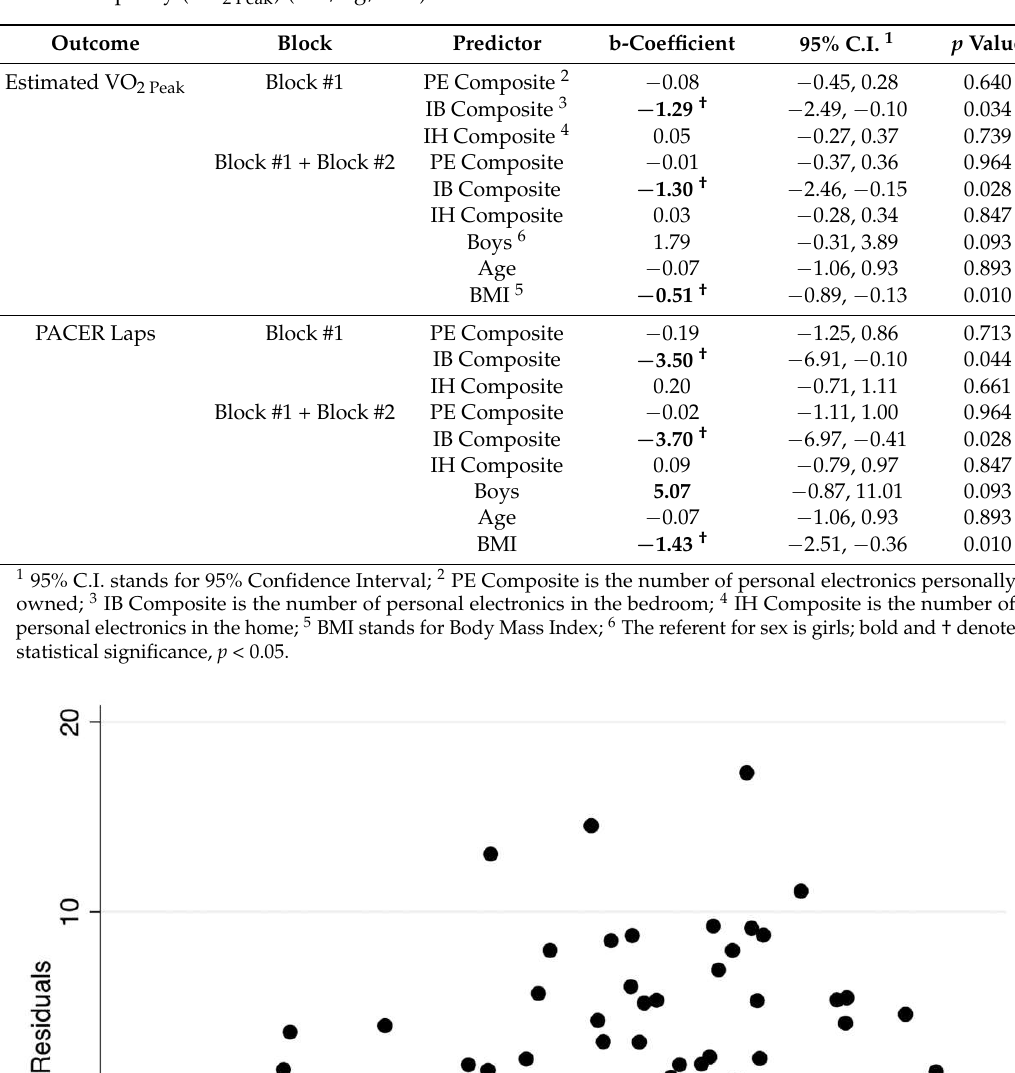
Table 2. Parameter estimates from hierarchical ridge regression models for the estimated maximal aerobic capacity (VO 2 Peak ) (mL/kg/min).